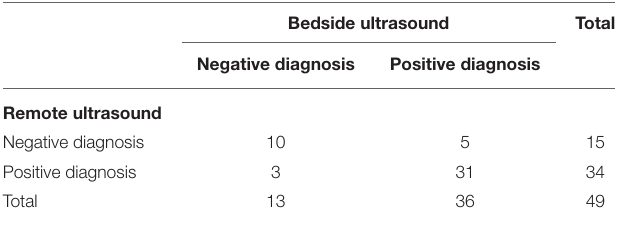
TABLE 1 | Demographic and clinical characteristics of the patients included in this study. Patient information